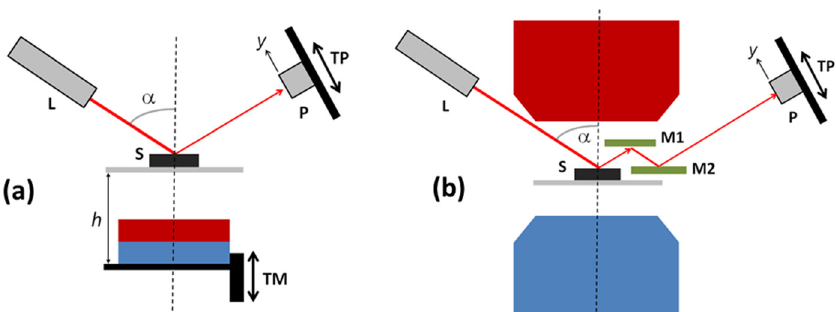
Figure 1. The spread optical reflectance setup ( a ) with a permanent magnet and ( b ) with an electromagnet: The red and blue elements indicate the north and south poles of the magnet, respectively. The other elements are L, laser; S, sample; P, photodiode; TM, translation stage for a magnet; TP, translation stage for a photodiode; and M1 and M2, mirrors.